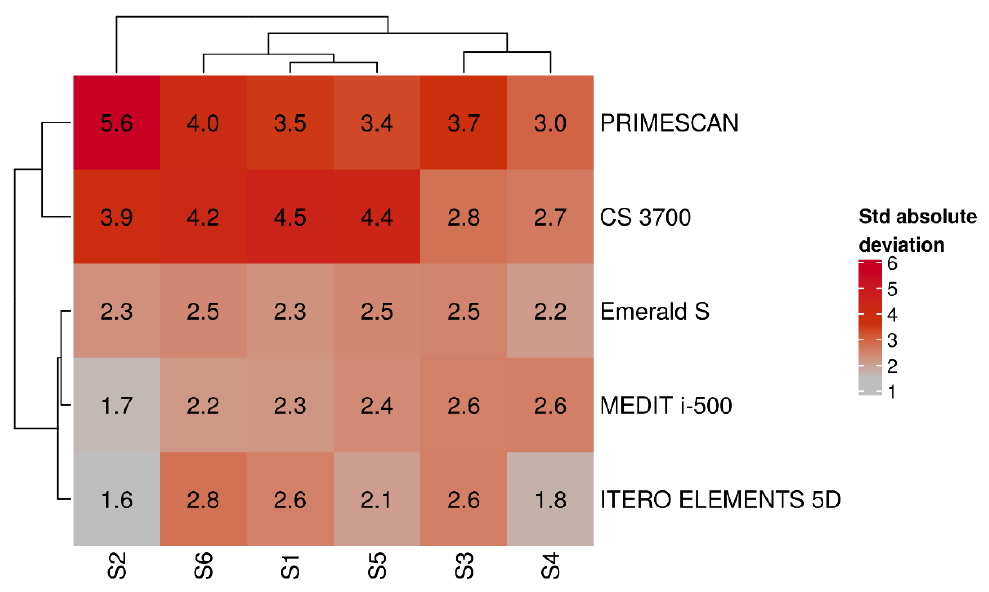
Figure 9. Results of IOSs and SBs biclustering based on standard deviation of absolute deviation.